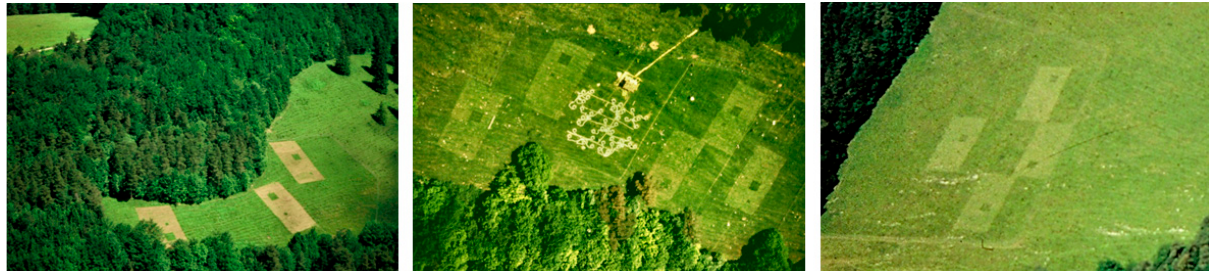
Figure 1. Study sites with the twelve experimental blocks photographed on 11 May 1994. Three experimental blocks were near Movelier (left), five near Nenzlingen (middle), and four near Vicques (right) in dry calcareous grasslands in the Jura mountains. Block halves containing fragments surrounded by a mown isolation area are clearly visible, while block halves with control plots are indistinguishable from the adjacent undisturbed grasslands. The study sites were fenced to exclude grazing by large herbivores. In the study site near Nenzlingen, other experiments were also conducted, and their infrastructure is visible between the blocks. Photos: M. Wurtz.